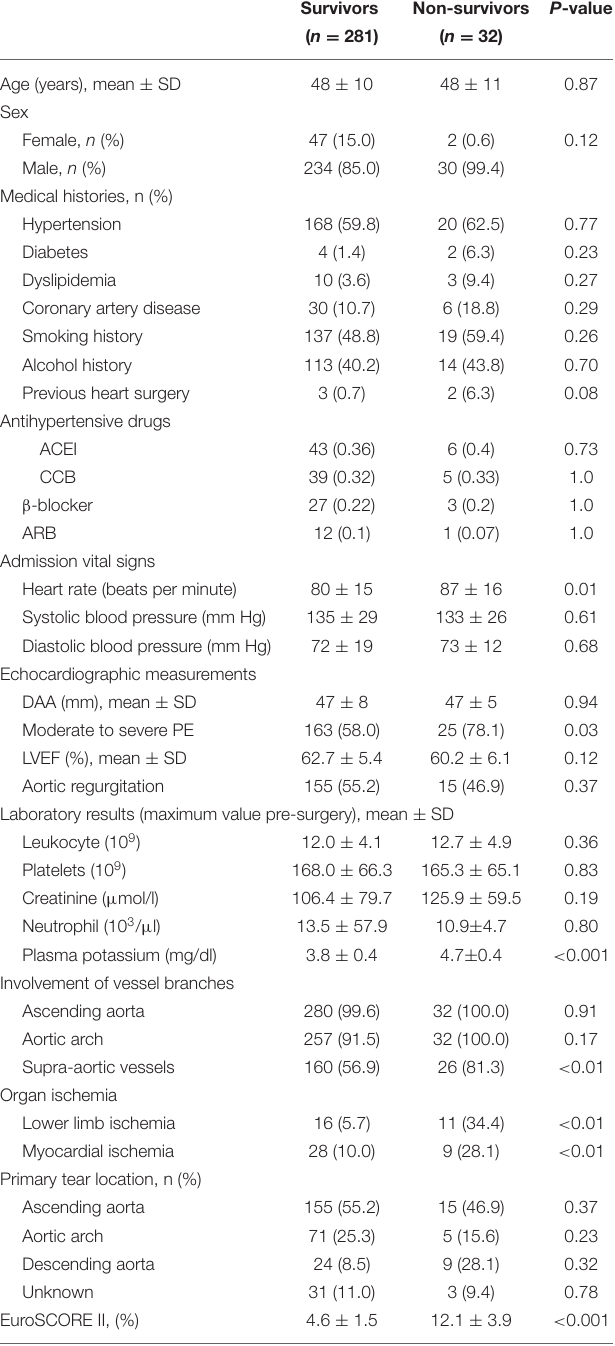
TABLE 2 | Procedure characteristics of patients with ATAAD. TABLE 1 | Pre-operative characteristics of patients with ATAAD. Survivors Non-survivors P -value Survivors